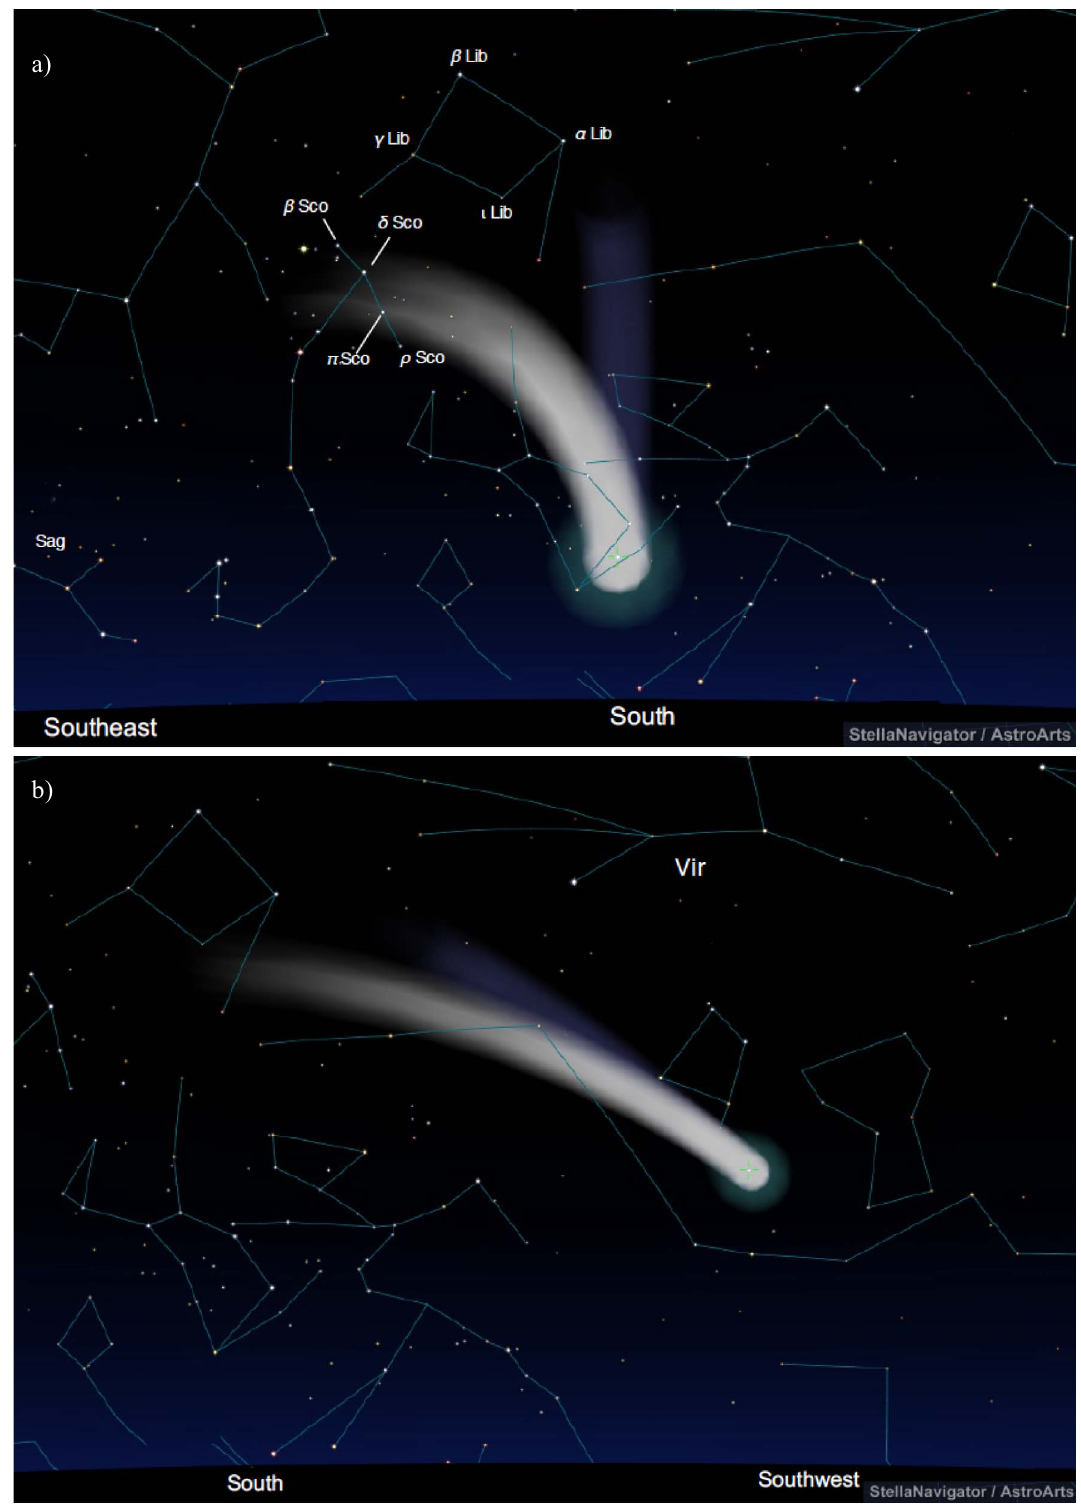
Fig. 6. Calculated cometary tails during nights of (a) 837 April 10/11 (April 11, 01:00 LMT) and (b) 837 April 11/12 (April 12, 0:00 LMT) with Stella Navigator 11 using orbit element in Marsden & Williams (2008) and Yeomans & Kiang (1981). During the night of April 10/11, 837, its dust tail (white) was shown directed towards Fáng ( p Sco, q Sco, d Sco, and b Sco) and its plasma tail (blue) directed towards a Lib in the western part of D ī